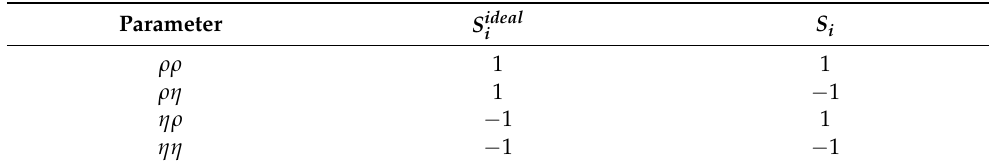
Table 4. Benchmark information in the similarity